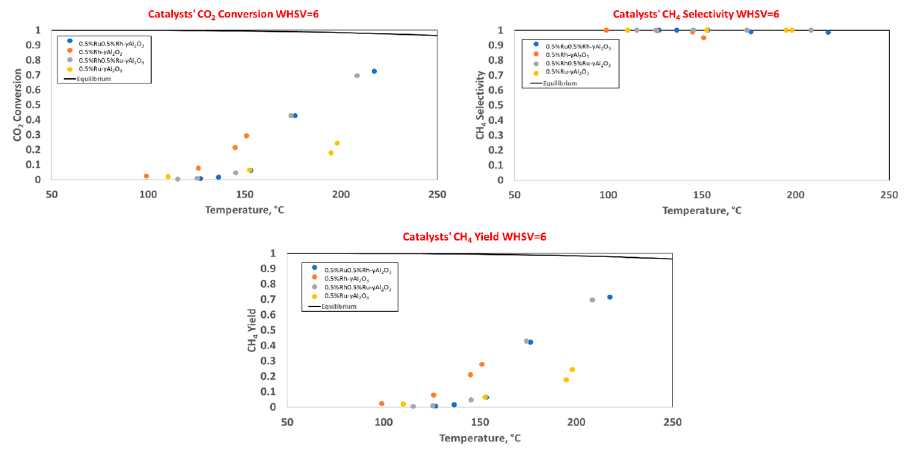
Figure 11. Catalysts’ CO 2 conversion, CH 4 selectivity and yield in non-thermal-plasma-assisted tests at WHSV = 6 NL/g cat h.